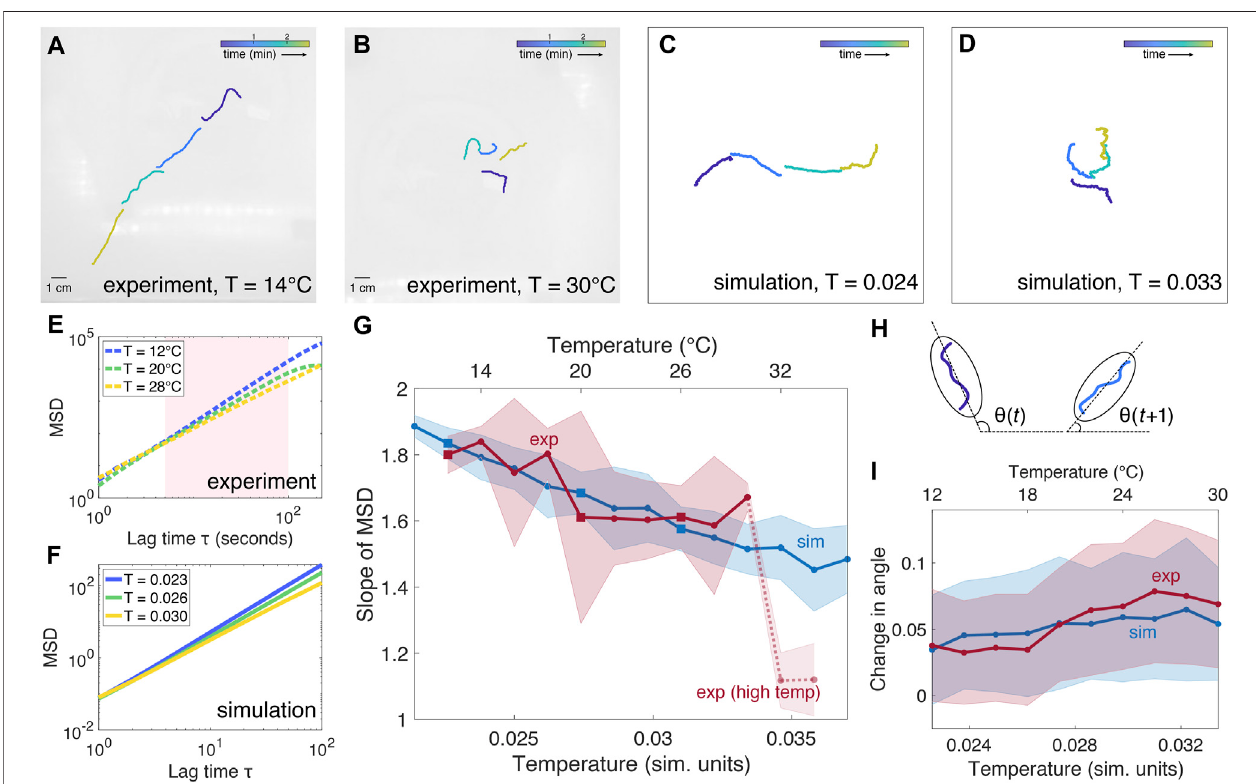
FIGURE 2 | Active polymer model of a single worm. (A – B) : Snapshots of single worm experiments at T (cid:1) 14 ° C and T (cid:1) 30 ° C, respectively. Worms are colored in software to visualize time progression. (C – D) : Snapshots of simulated single worm conformations at T (cid:1) 0.024 and T (cid:1) 0.033 (simulation units), respectively. (E) : Examples of mean squared displacement (MSD) as a function of lag time τ from three separate experimental trials at three different temperatures, indicated by the squaresinpanel (G) .BecausetheMSDisnotlinearovertheentirerangeof τ ,theslopeiscomputed fortheregionshadedinpink. (F) :ExamplesofMSDfromthree simulations at three different temperatures, indicated by the squares in panel (G) . (G) : Comparison of mean slope ± SD of mean squared displacement (MSD) as a function of temperature for simulation (blue) and experiment (red, 5 trials). The slope of MSD generally decreases with increasing temperature. Experimental data at T (cid:1) 32 – 34 ° C are indicated by a dashed line, as worm physiology is likely to be affected by the high temperature. Squares indicate temperatures at which examples of MSD areplottedinpanels (E – F) . (H) :Theangle θ attime t iscomputedby fi ttinganellipsetothewormandcalculatingtheangleofthemajoraxiswithrespecttothehorizontal. The average change in angle between consecutive timesteps θ ( t + 1) − θ ( t ) is used as a measure of worm fl uctuations. (I) : For the trials analyzed in panel (G) , the average change in angle θ increases with temperature for both simulation and experiment.